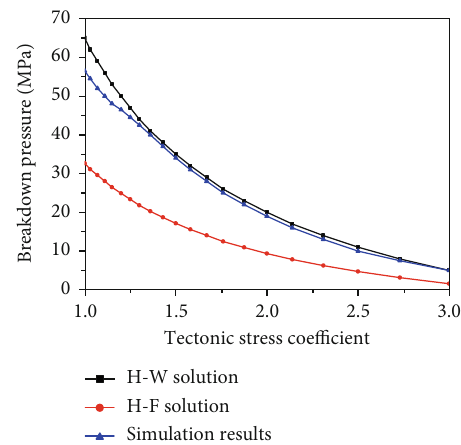
Figure 5: The breakdown pressures under di ff erent tectonic stress coe ffi cients obtained by H-W solution, H-F solution, and numerical simulation.